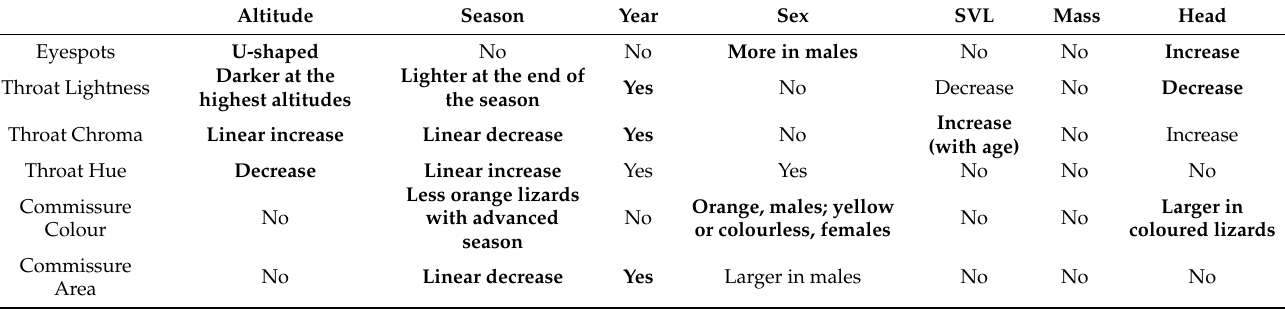
Figure 8. Frequency of lizards with colourless, yellow or orange commissure according to age ( A ) and average (with SE) throat chroma according to age ( B ).